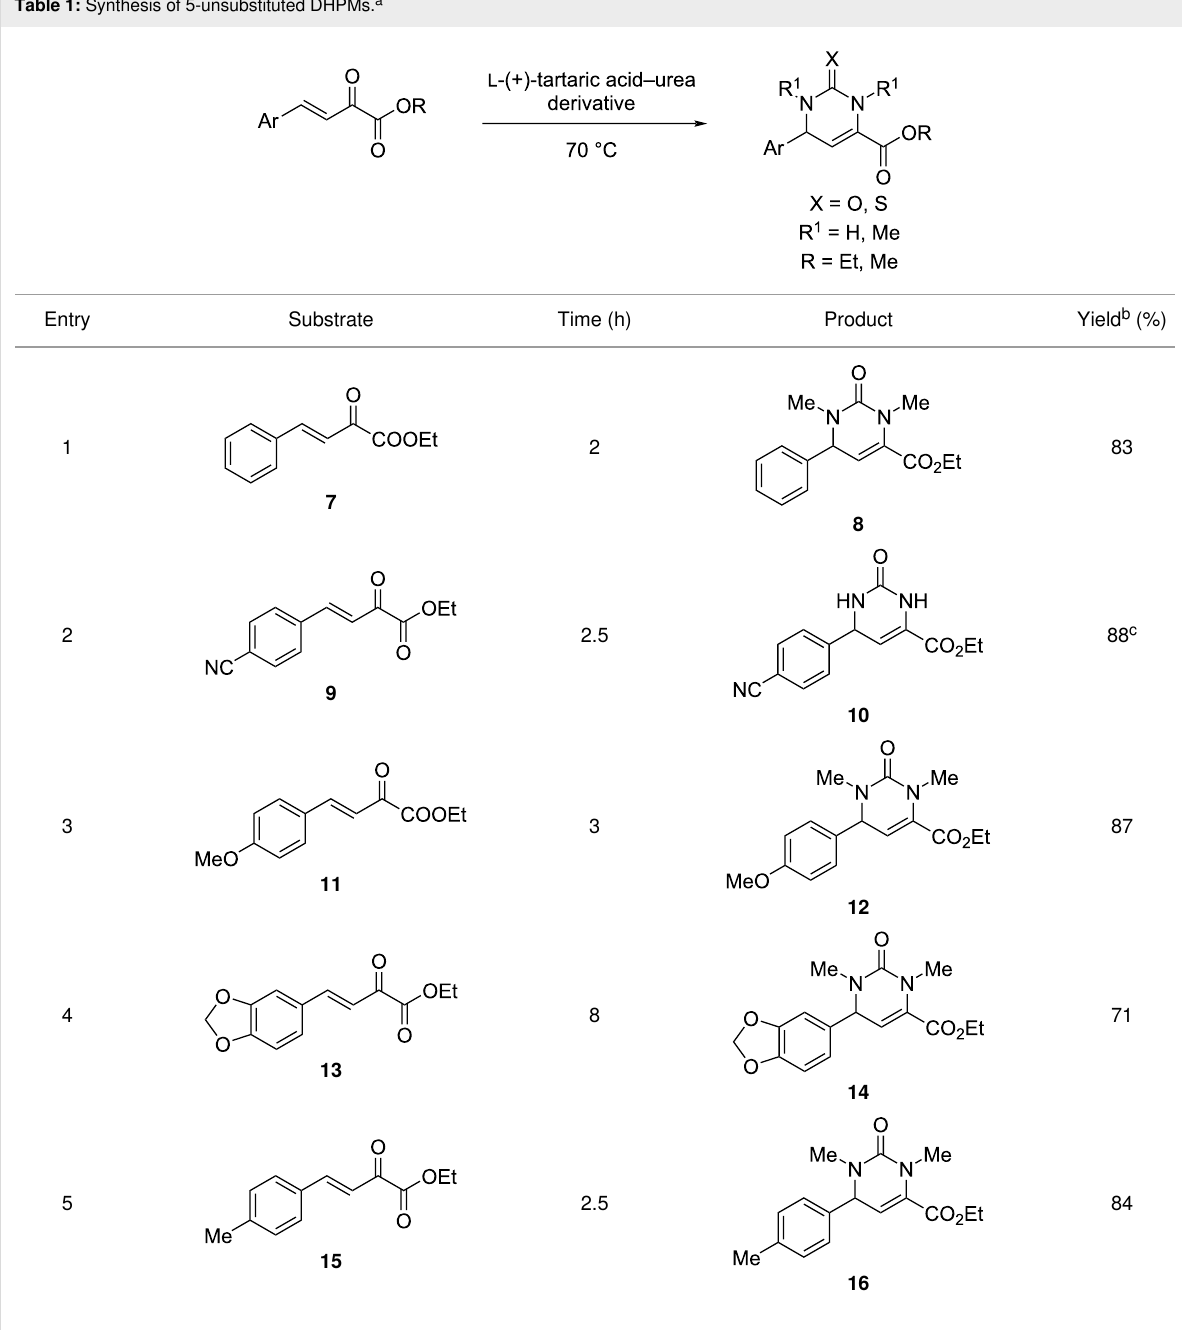
Table 1: Synthesis of 5-unsubstituted DHPMs.